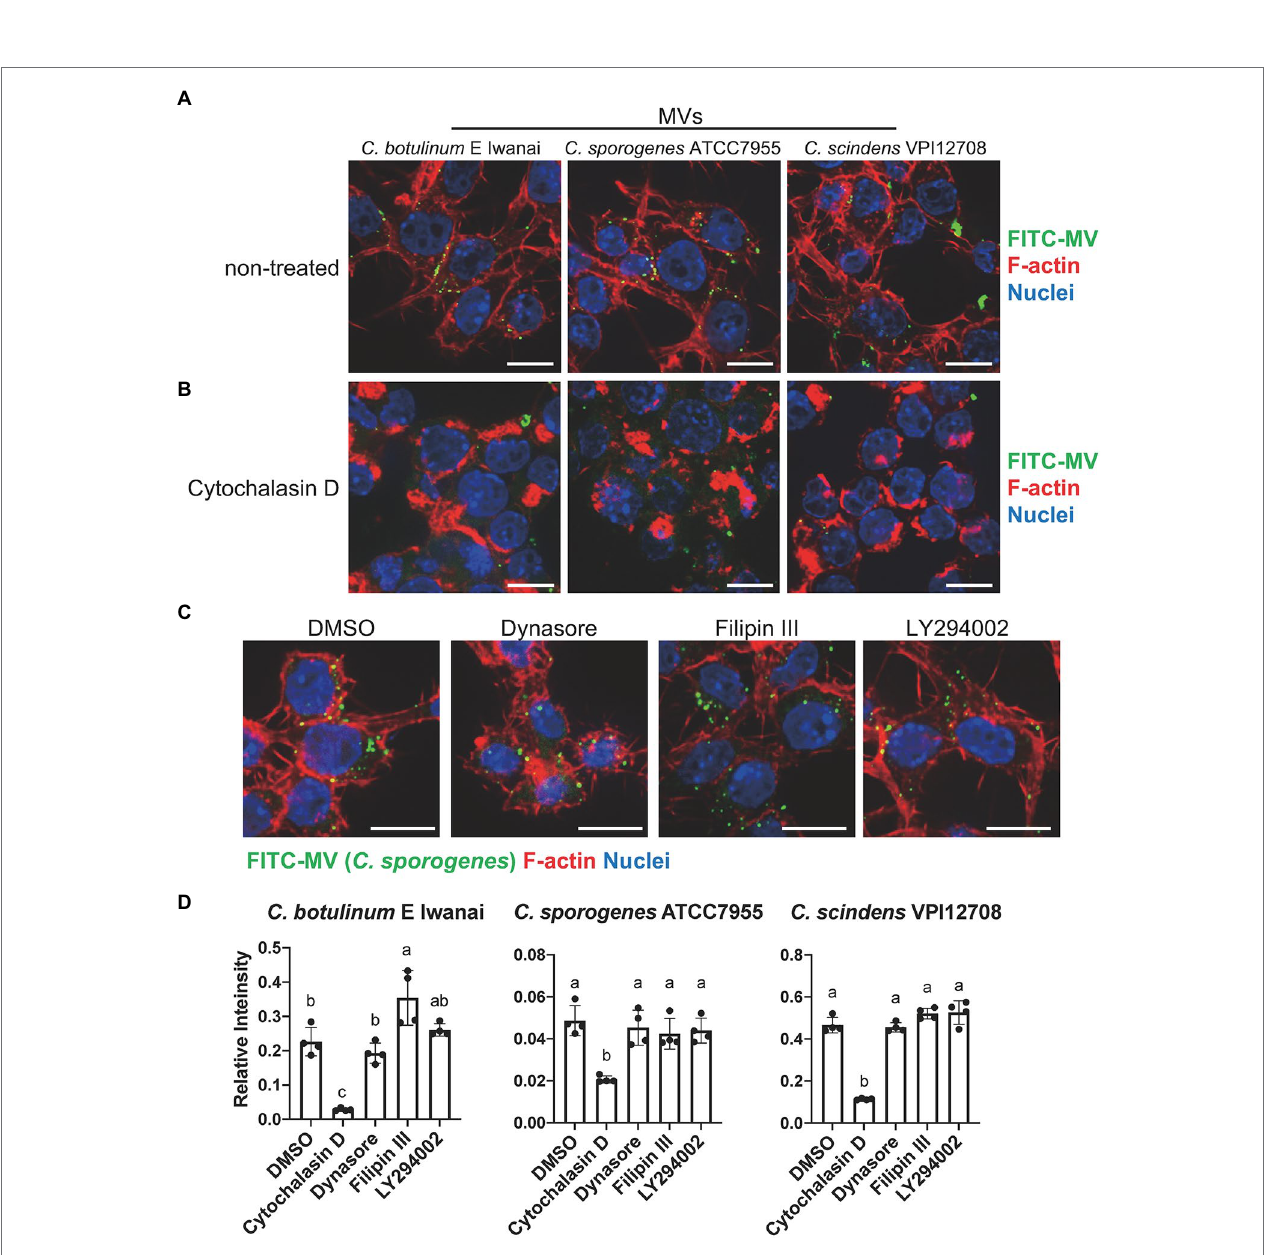
FIGURE 5 | Uptake of clostridial MVs in RAW264.7 macrophages. (A) A fluorescence microscopy analysis of MV localization in RAW264.7 cells. Cells were treated with 50 μ g/ml FITC-labeled MVs for 1 h. Bars, 10 μ m. (B) Inhibitory effects of 10 μ M cytochalasin D on MV uptake. (C) Effects of 80 μ M dynasore, 20 μ g/ml filipin III, and 10 μ M LY294002, which inhibit dynamin, lipid rafts, and PI3K, respectively, on MV uptake. Bars, 10 μ m. (D) Quantification of fluorescence intensity of cell lysates. FITC intensity was normalized by that of Hoechst33342. Means that do not share a letter are significantly different ( p < 0.05). Error bars indicate SD. n =